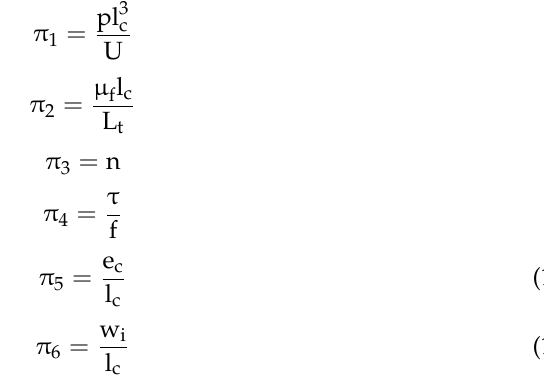
Table 1. Variables and their corresponding dimensions in the MLTI system for dimensional analysis of the EM pressure for MPW of tubes. Variable Symbol Dimension EM pressure (Pa) p ML − 1 T − 2 Discharge energy (J) U ML 2 T − 2 Magnetic permeability of flyer (H/m) µ f MLT − 2 I − 2 Number of turns n - Length of coil (m) l c Thickness of coil (m) Total inductance (H) Discharge frequency (Hz) Damping constant (s − 1 ) τ Field shaper inner length (m) w i